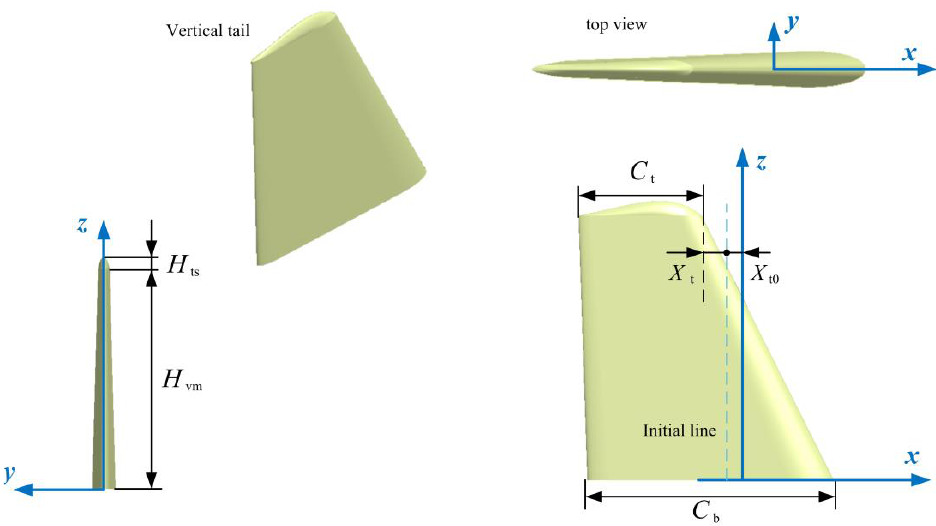
Figure 5. Model of the vertical tail.